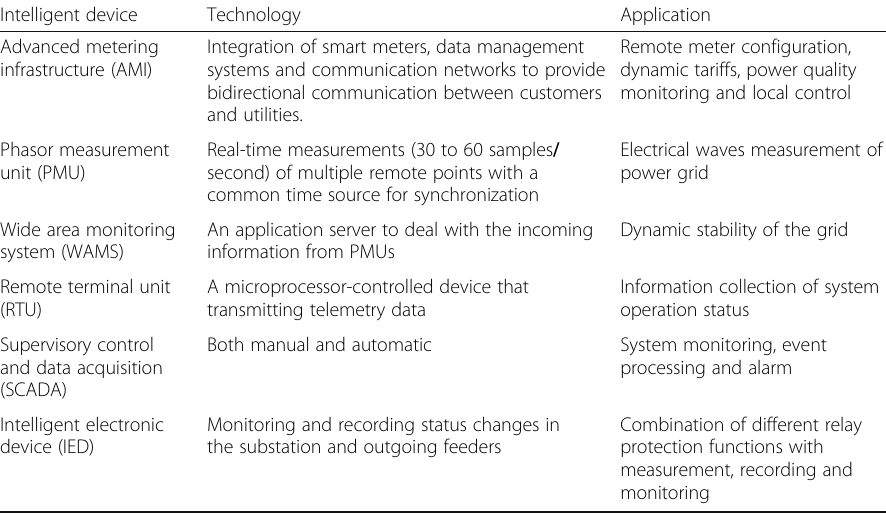
Table 2 Intelligent data collection devices in smart grid